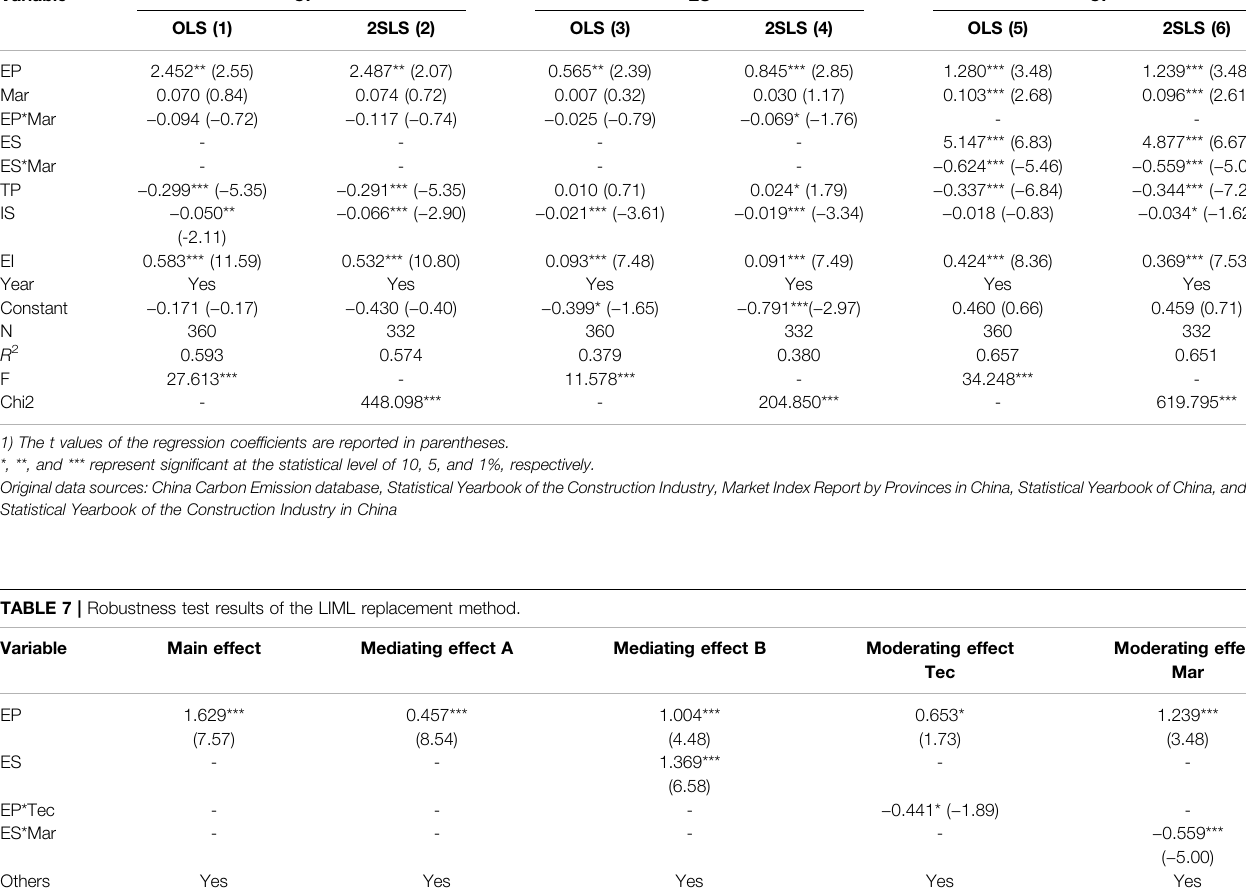
TABLE 6 | Test of the moderating effect of the marketization degree. Variable